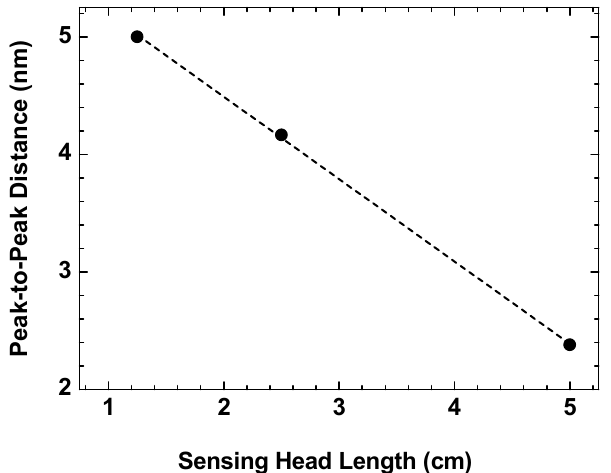
Figure 4. Experimental variation of the peak-to-peak distance of the fringes of the interferometric output with the sensing head